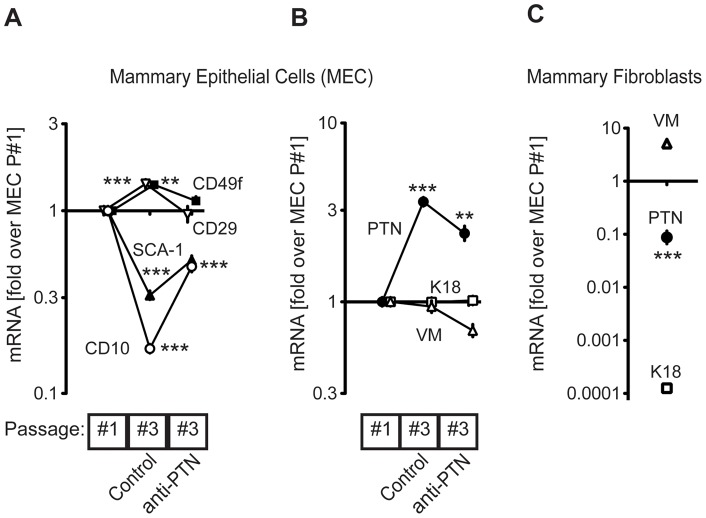
PTN effect on cultured mammary epithelial cell (MEC) differentiation.(A, B) Effect of treatment of MECs with a blocking anti-PTN antibody. (A) Progenitor marker mRNA, (B) Keratin 18 (K18), Vimentin (VM) and PTN mRNA expression were measured by quantitative, real-time PCR. The effect of continuous passaging of MECs ± anti-PTN is shown relative to passage #1 MECs. Data are means ± SE; n = 4 and 2 independent experiments for VM and K18 respectively; **P <0.01; ***P <0.001 by ANOVA. MECs passage#1 expression relative to Actin: CD29, 3.5; CD49f, 5.6; CD10, 6.6; SCA-1, 2.3; K18, 2.9; VM, 5.3; PTN, 12.2. Control MECs passage#3 expression relative to Actin: CD29, 2.9; CD49f, 5.1; CD10, 9; SCA-1, 3.8; K18, 2.9; VM, 5.5; PTN, 10.3. Treated MECs passage#3 expression relative to Actin: CD29, 3.5; CD49f, 5.4; CD10, 7.5; SCA-1, 3.2; K18, 2.9; VM, 5.9; PTN, 10.9. (C) Expression of K18, VM and PTN in mammary fibroblasts relative to MECs passage #1. Expression of K18, VM and PTN in mammary fibroblasts relative to Actin: PTN, 15.7; K18, 15.9; VM, 3.